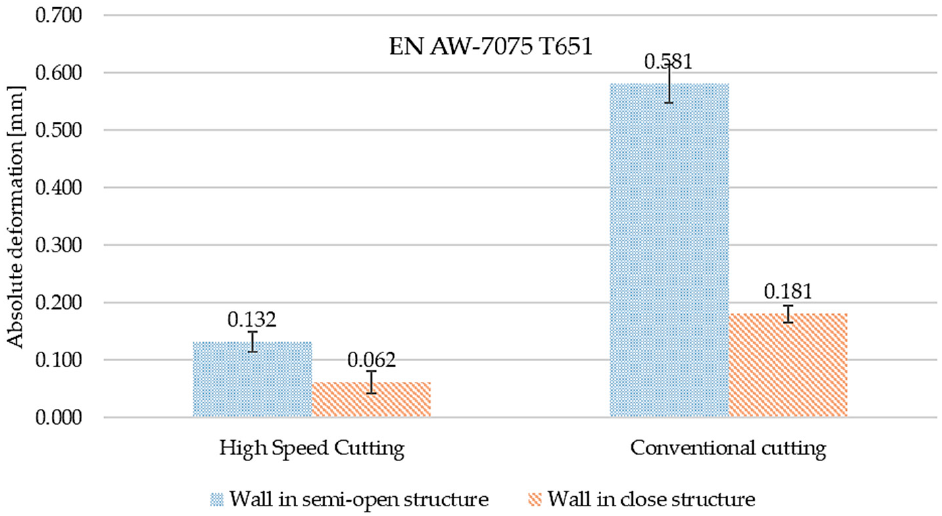
Figure 16. The comparison of maximum absolute deformation values depending on finishing machining and the type of structure for the EN AW-7075 T651 aluminium alloy.